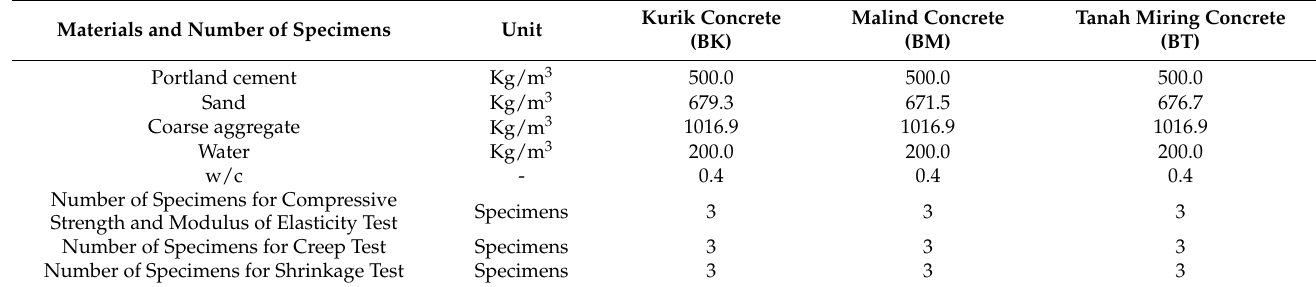
Table 4. Mix proportions of concrete and number of